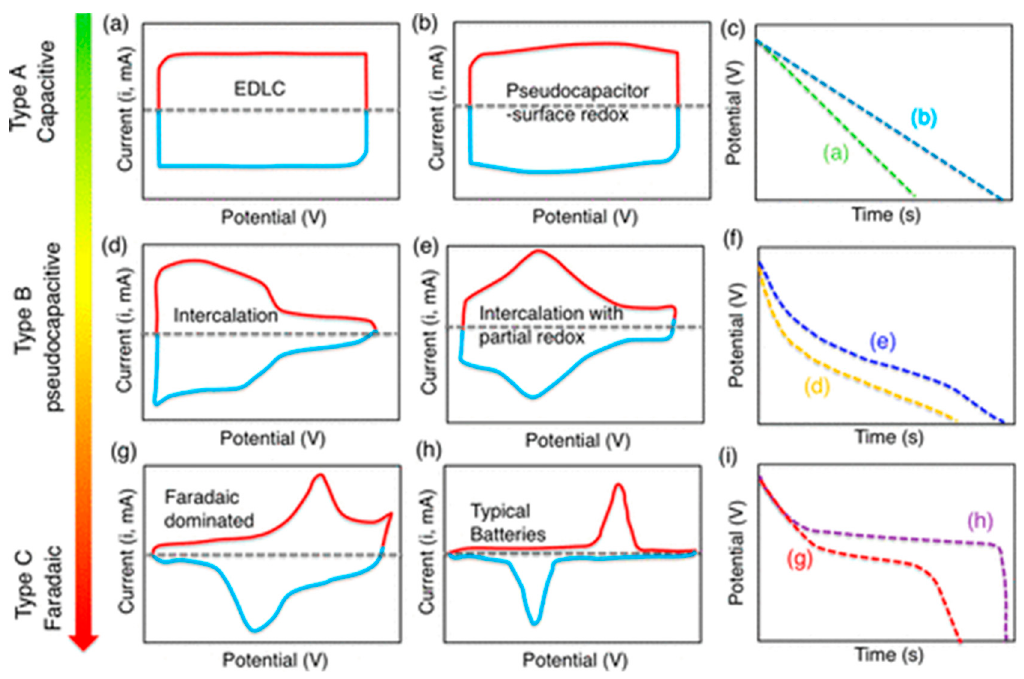
Figure 3. Schematic CV profiles ( a , b , d , e , g , h ) and corresponding galvanostatic discharge curves ( c , f , i ) for different type of electrode materials